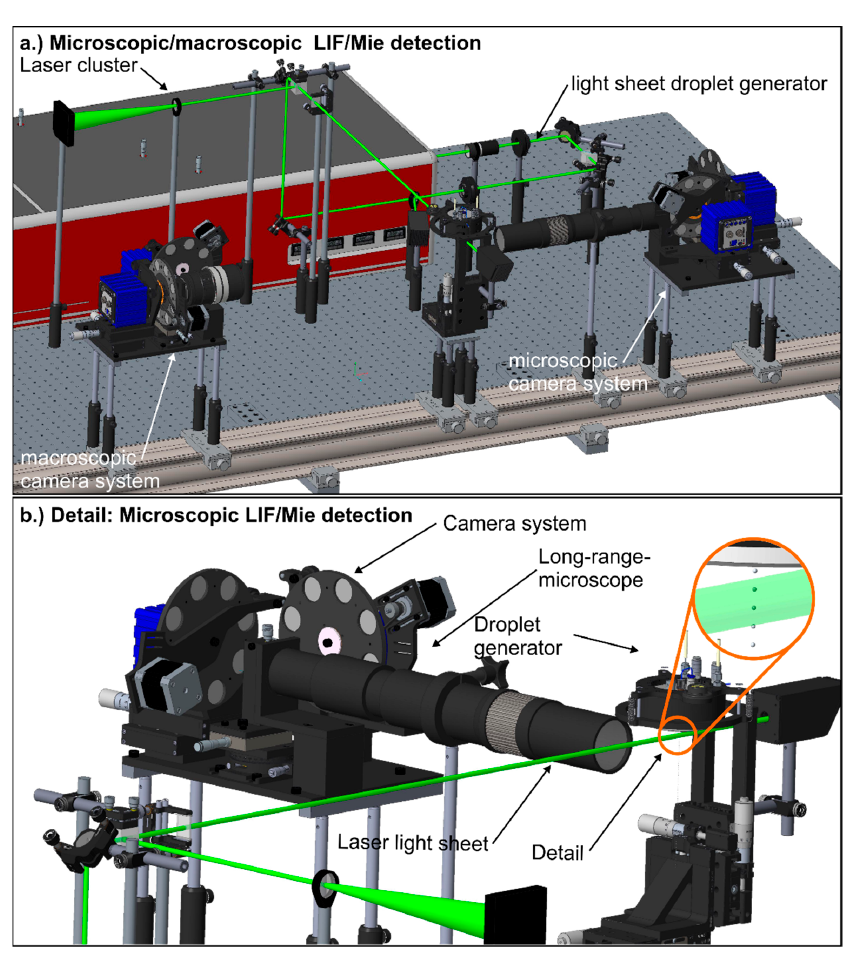
Figure 1. Optical setup for the simultaneous microscopic and macroscopic LIF / Mie detection ( a ). Detail for the microscopic detection and the droplet generator ( b ).